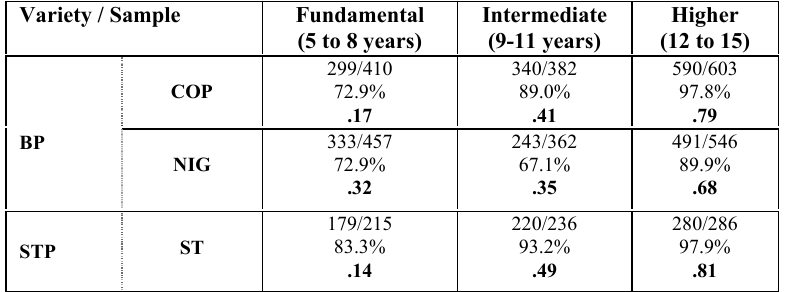
Table XIII: Third person plural verbal marking in EP and Education by variety of